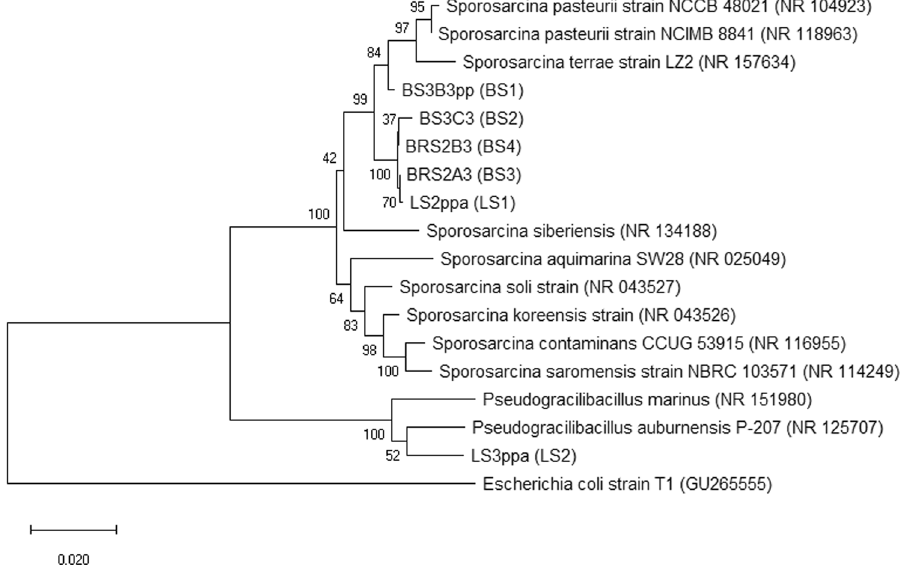
Figure 3. Neighbor-joining phylogenetic tree based on the 16S rRNA sequence of the isolates and reference sequence from the GenBank database